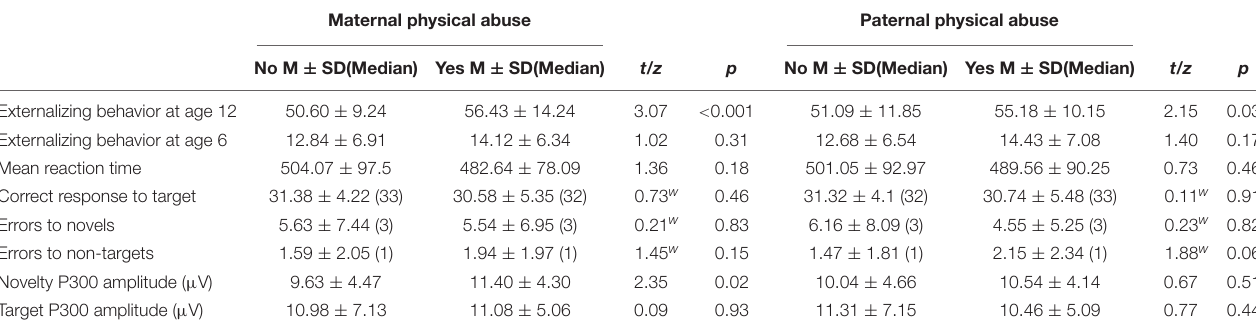
FIGURE 1 | The full mediation model. The model illustrates the relationship between maternal and paternal physical abuse and self-reported externalizing behaviors and the mediating role of P300. The variable P300 refers to any of the following variables: novelty P300 amplitude and target P300 amplitude. All the variables in the figure were measured at age 12. The model was adjusted child sex, socioeconomic status, area of residence, IQ at age 12, anxiety at age 12 and externalizing behaviors in preschool at age 6. TABLE 2 | Comparisons of behavior problems, performance on oddball task and P300 between physically abused children and their non-abused counterparts. Maternal physical abuse Paternal physical